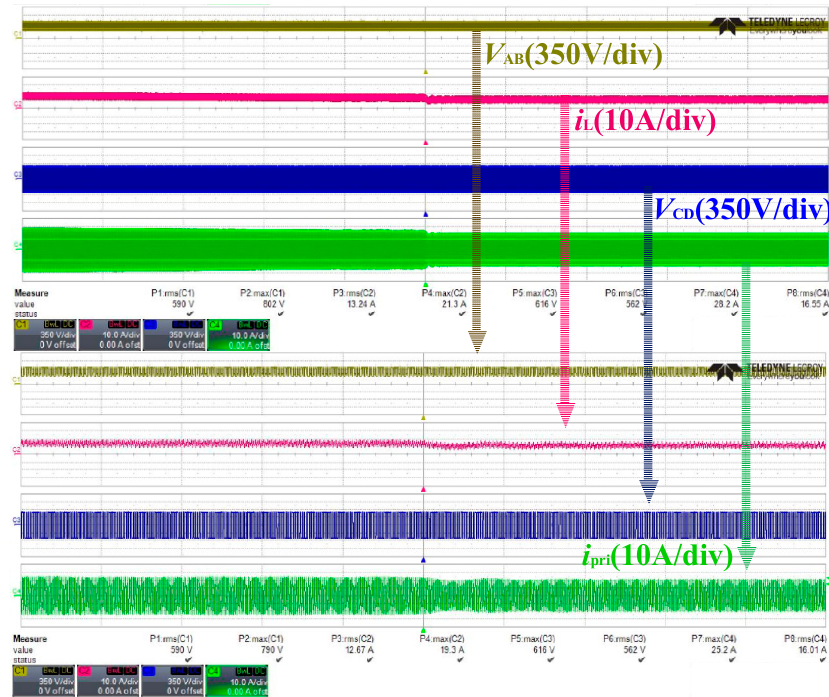
Figure 23. Transient waveforms during a step-up of resistive load from R 0 = 16 Ω to R 0 = 27 Ω .